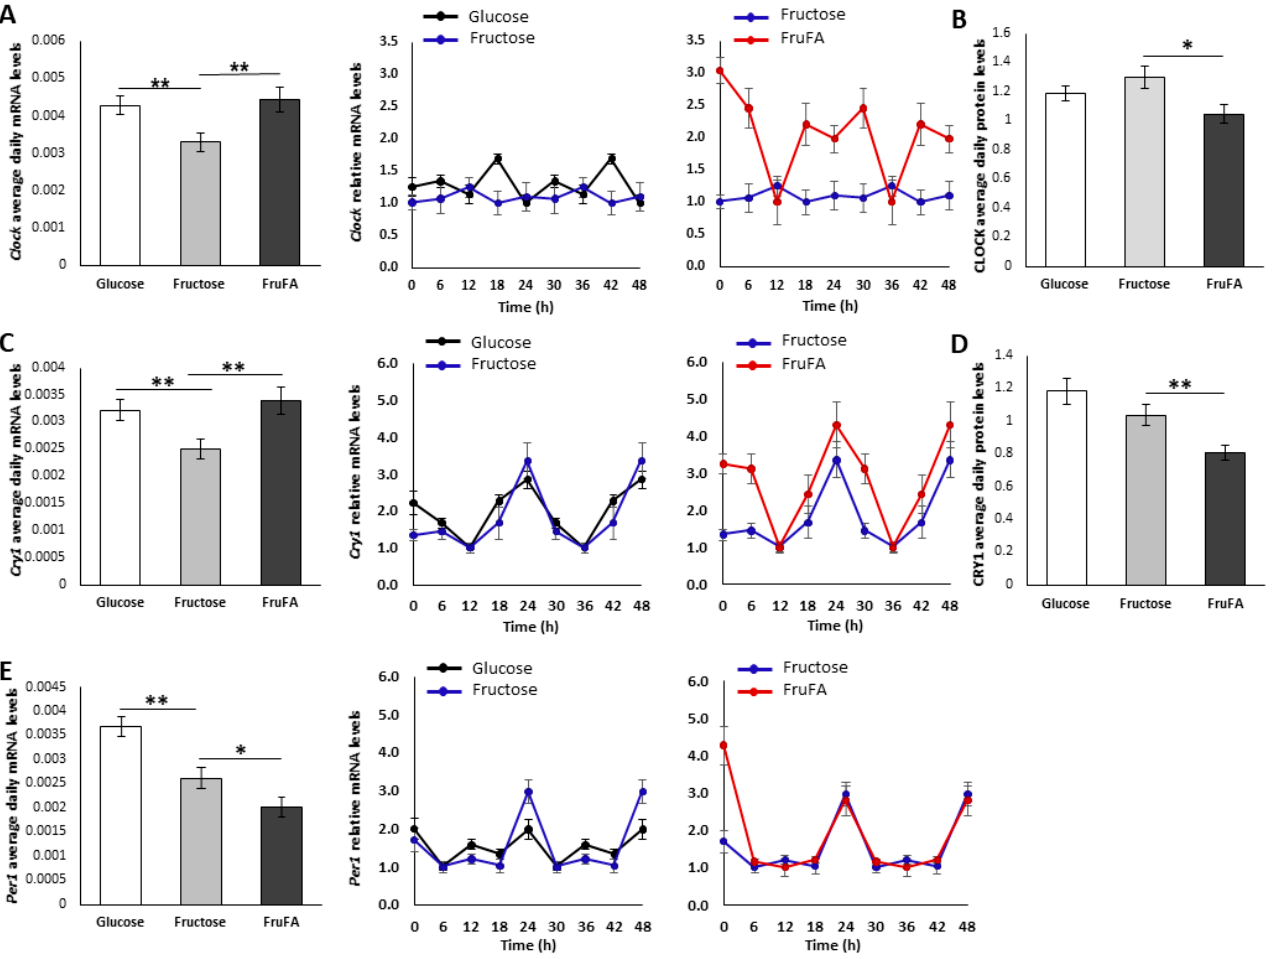
Figure 5. Effect of fructose and fructose-induced steatosis on circadian rhythms in AML-12 hepa- tocytes. ( A ) Average daily levels and expression of Clock mRNA. ( B ) Average daily protein levels of CLOCK. ( C ) Average daily levels and expression of Cry1 mRNA. ( D ) Average daily protein levels of CRY1. ( E ) Average daily levels and expression of Per1 mRNA. One hundred and fifty thousand cells per mL were used in each treatment. Values are means ± SE. Asterisks denote significant differences by t -test (* p < 0.05; ** p <